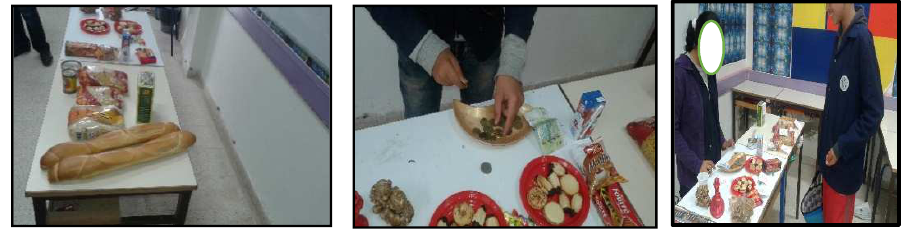
Tableau 5 : Les résultats du pré et du post-test de l’échantillon témoin